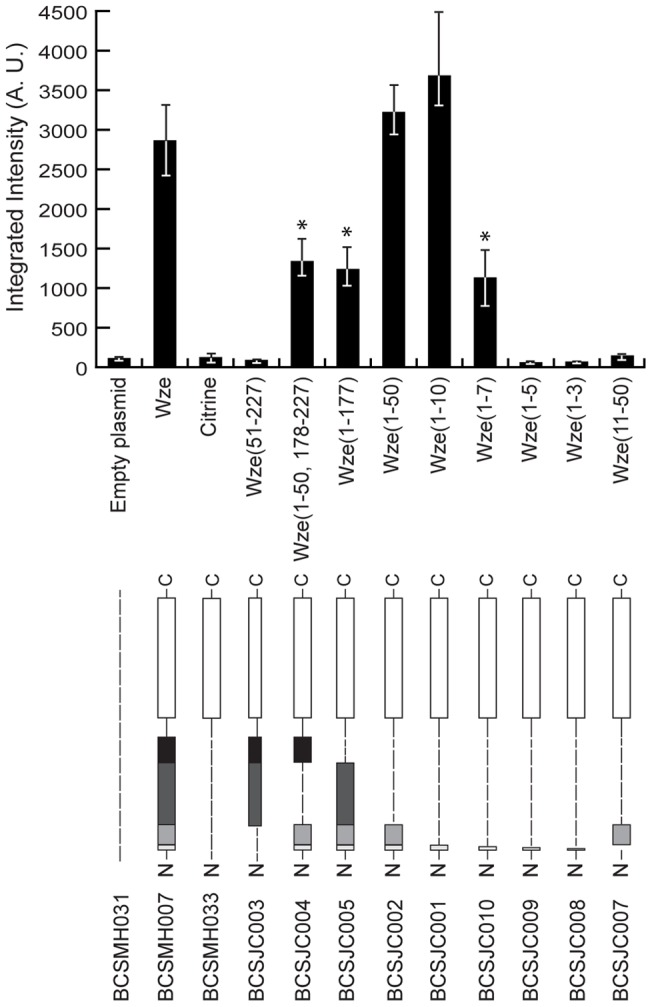
The first ten amino acids of Wze are required to obtain high levels of fluorescence.(Upper panel) Median fluorescence, with 25% (white error bars) and 75% (black error bars) inter-quartile range (in arbitrary units) emitted by Citrine fused to specific aminoacid sequences for Wze, as indicated below the graphic, in S. pneumoniae R36A strain. Strain BCSMH031 was used as a negative control. At least 100 cells of each strain were quantified. Exposure time was 5 sec. Kruskal-Wallis analysis with Dunn's multiple post-test comparison did not reveal significant differences between the BCSMH007 strain, expressing Wze-Citrine, and strains BCSJC001 and BCSJC002, expressing Citrine constructs that still carry the first 10 aminoacids of Wze (P>0.05). A significant reduction of the fluorescent signal was observed in strains BCSJC004, BCSJC005 and BCSJC010 (*, P<0.01). (Bottom panel) A schematic representation of each Wze constructs is shown. White box represent the Citrine protein while gray boxes represent different regions of Wze protein (lighter grey – aminoacids 1 to 10, light grey – remaining N-terminus region between aminoacids 11 to 50, dark grew – central region between aminoacids 51–176, black box – C-terminus region between aminoacids 178–227. Strain name are indicated below.